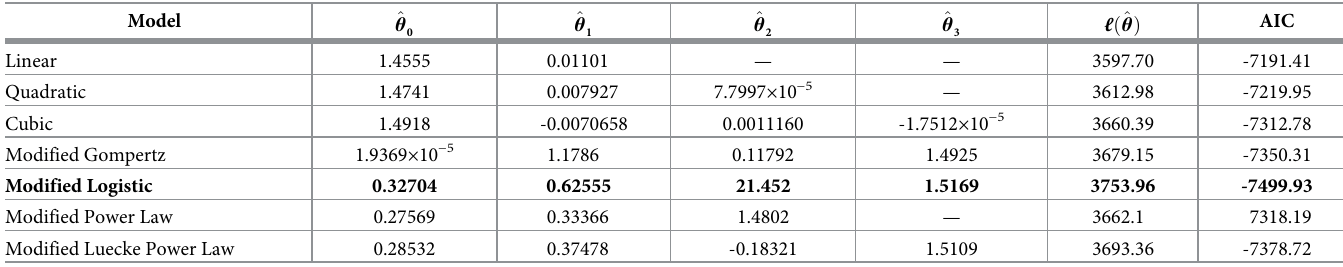
Table 10. Maternal RBC volume models (volume in L vs. fetal mass in kg for power law models, volume in L vs. gestational age in weeks for all other